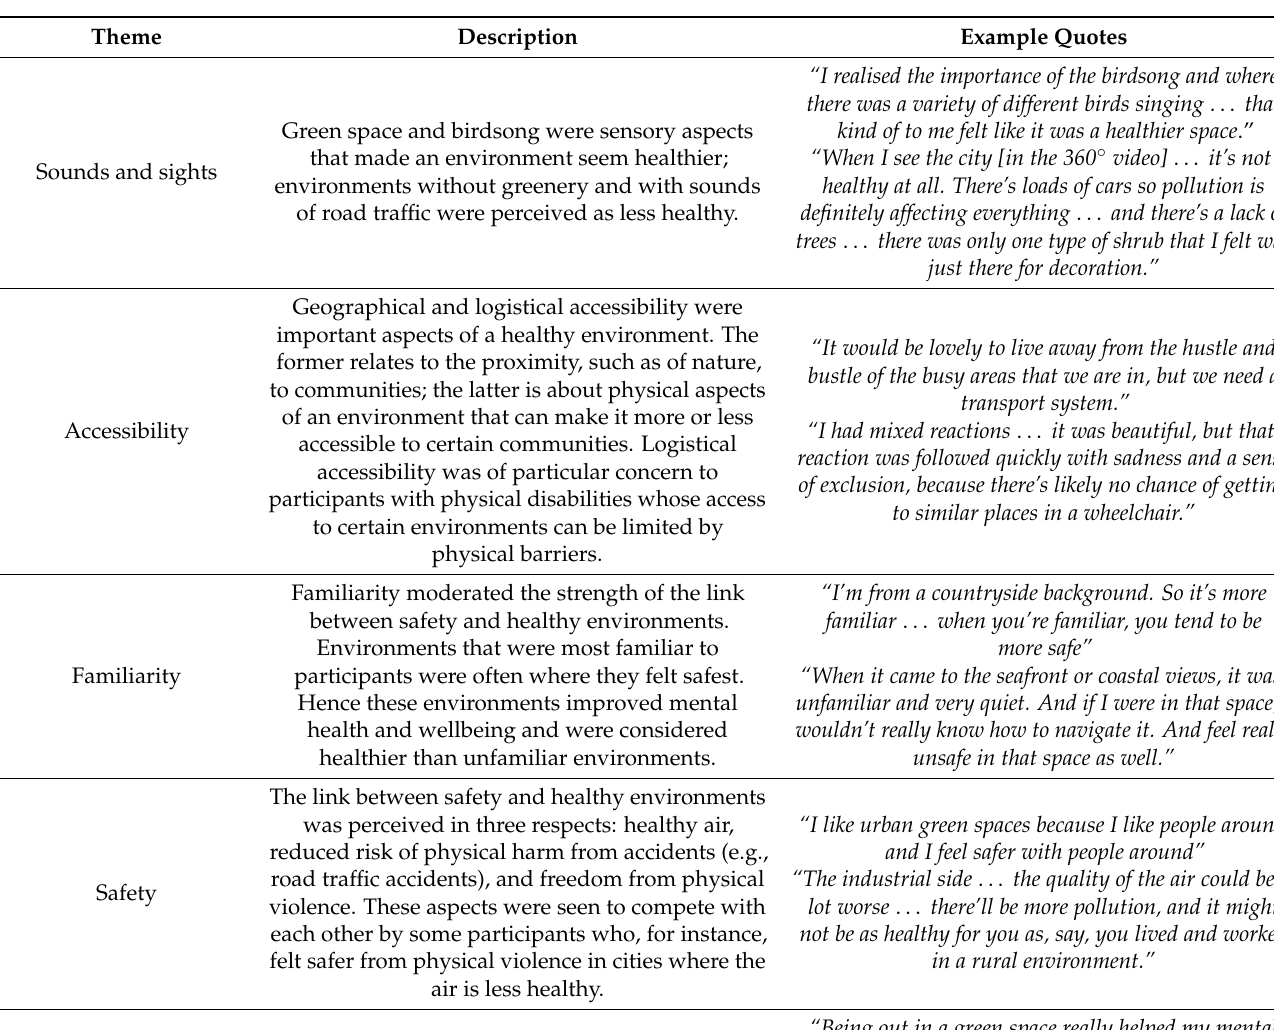
Table 3. Key themes and associated